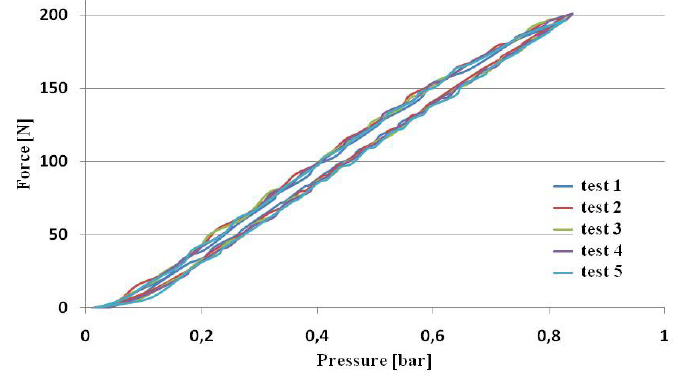
Figure 13. Force-pressure tests on a para-aramid